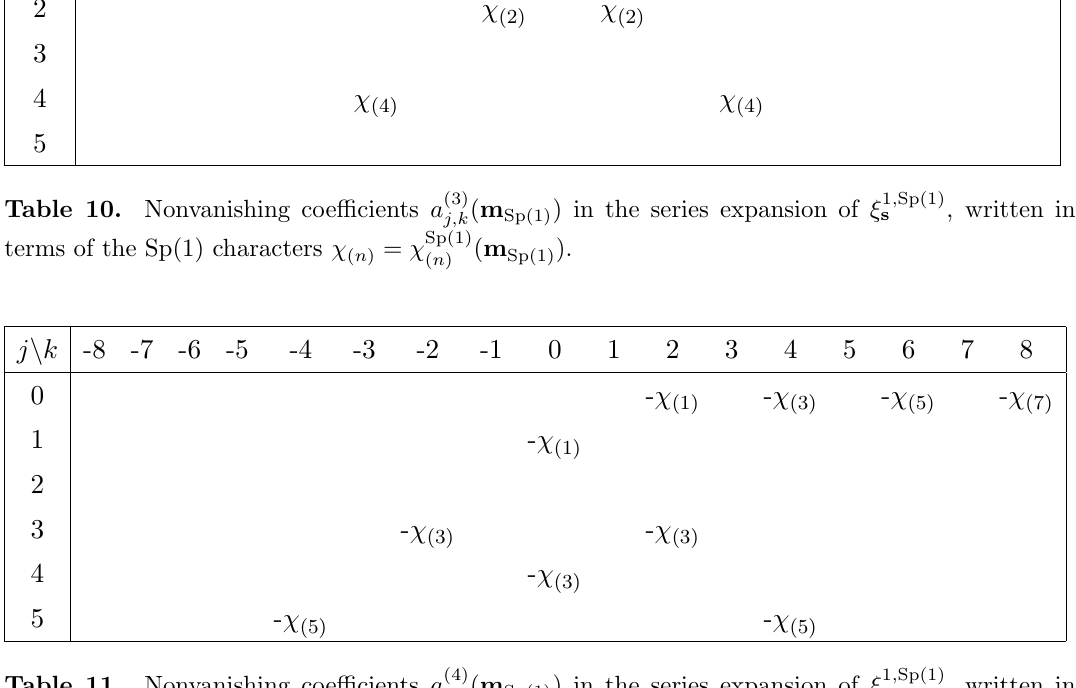
( m ) in the series expansion of (cid:24) 1 ; Sp(1) c , written in Sp(1) j;k = (cid:31) Sp(1) ( m ). ( n ) Sp(1) ( n )